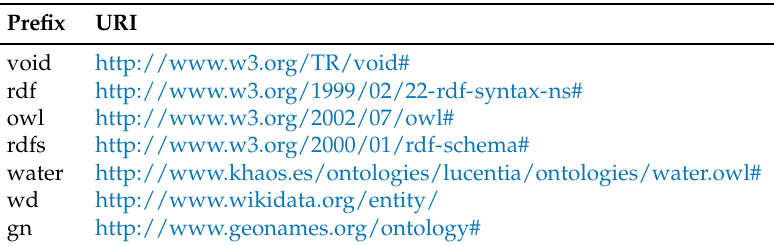
Table 5. Prefixes for